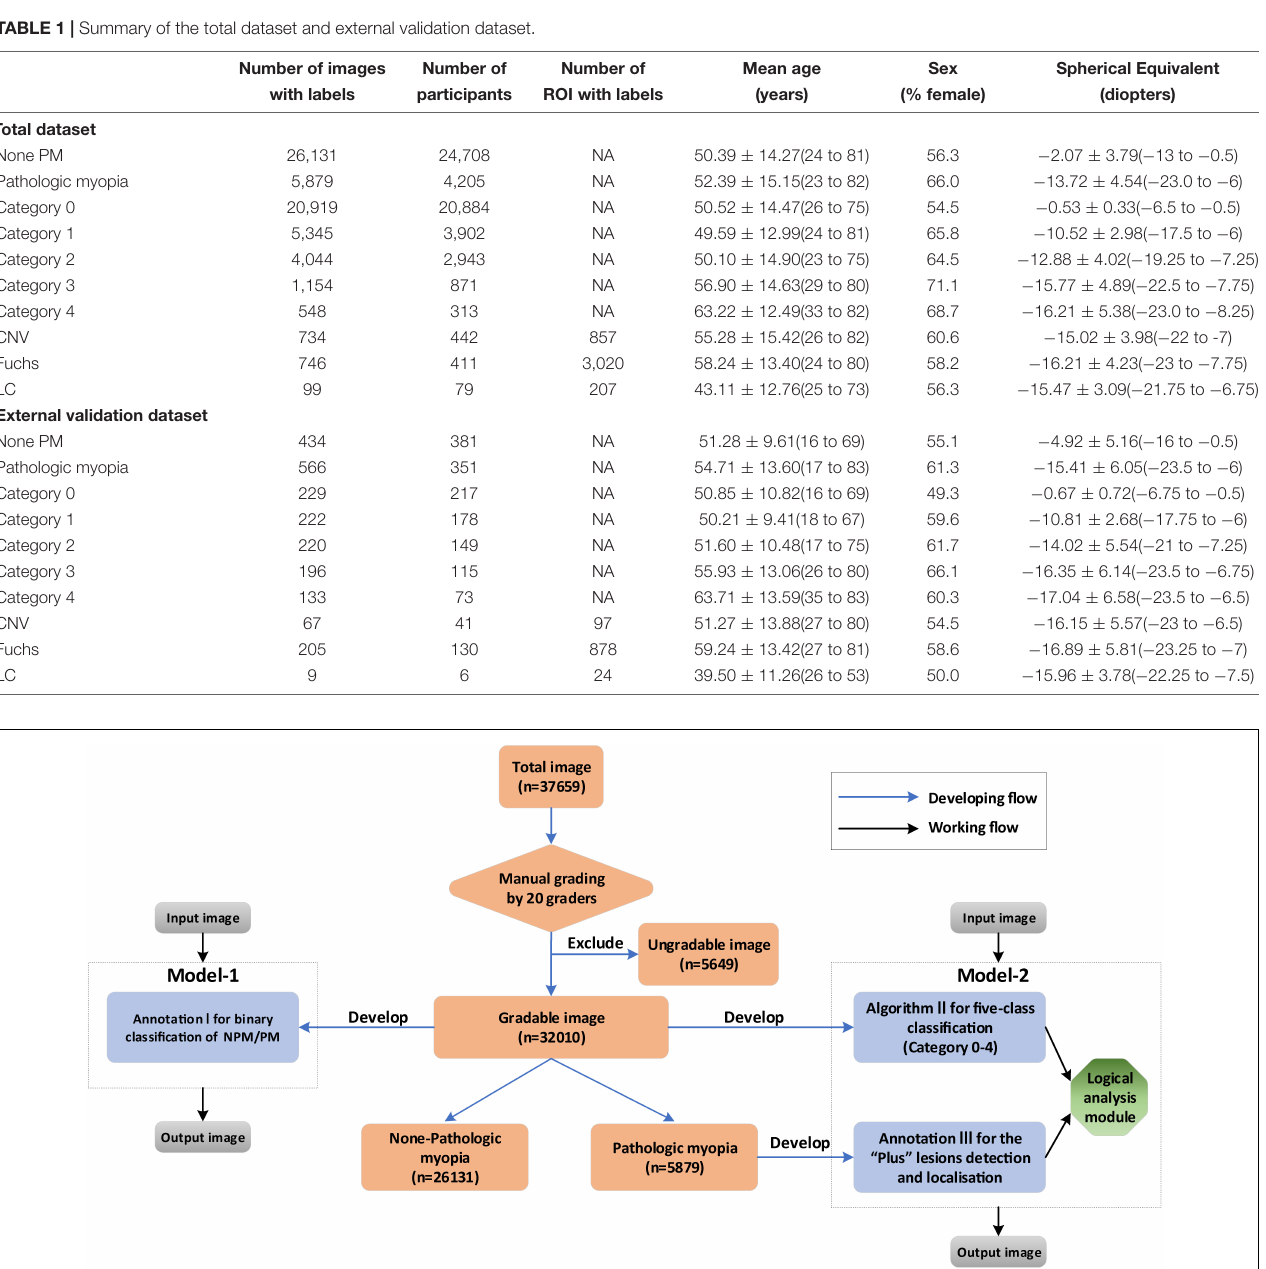
process was repeated five times to confirm that each fold was set as the testing set (Keenan et al.,